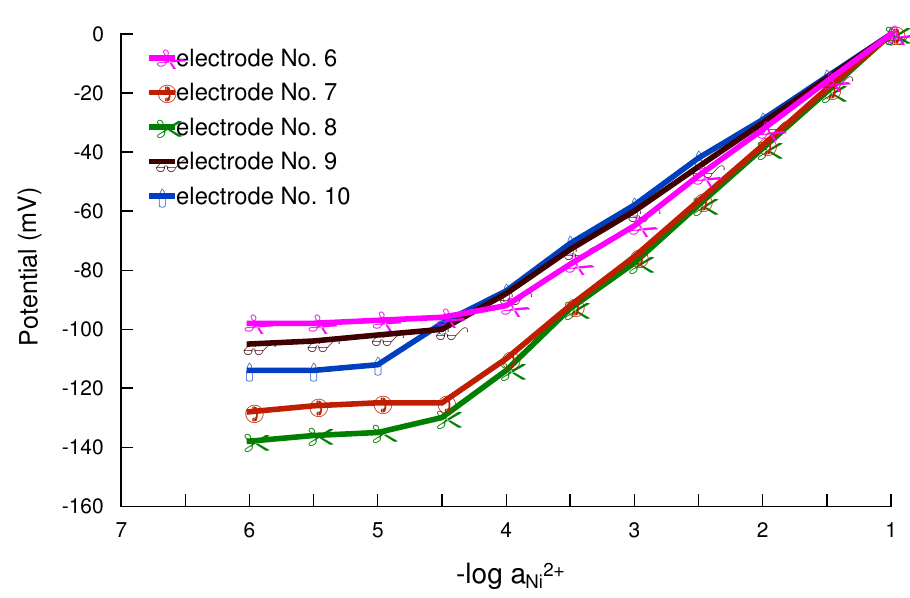
Figure 2: Variation of cell potential with Ni 2+ concentration; PVC based membranes of OMP without plasticizer (6), with plasticizers, DBP(7), DOP(8), DBBP(9) and